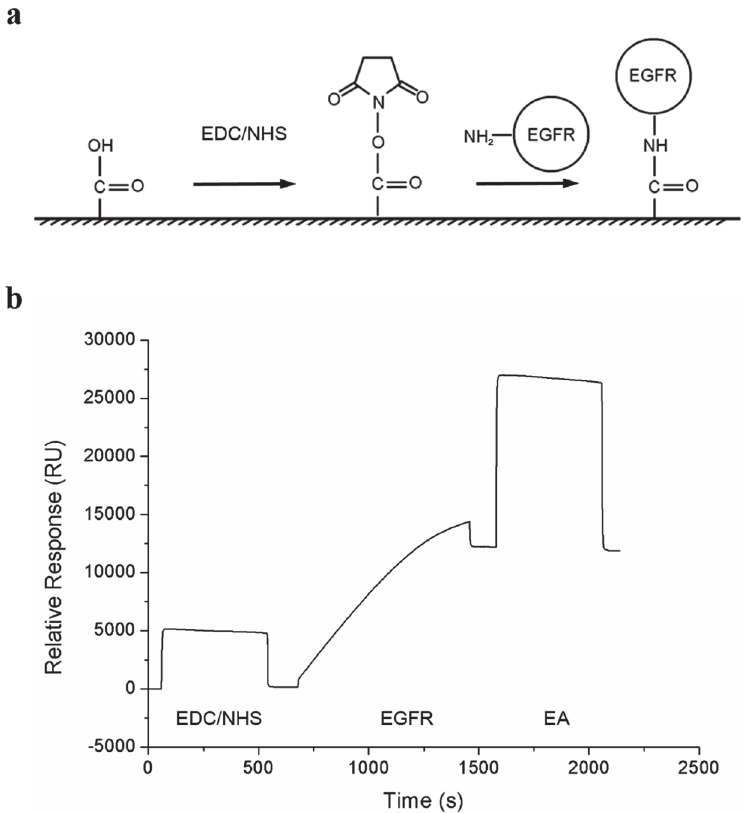
Fig 1. Immobilization of EGFR to the Sensor CM5 chips. (a) EGFR was immobilized to the surface of chip by amine coupling method. (b) SPR Sensorgram of the immobilization of EGFR.